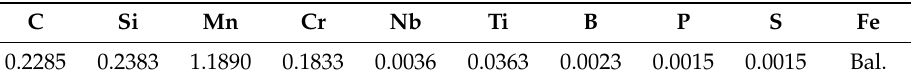
Table 1. Chemical composition (wt%) of Boron